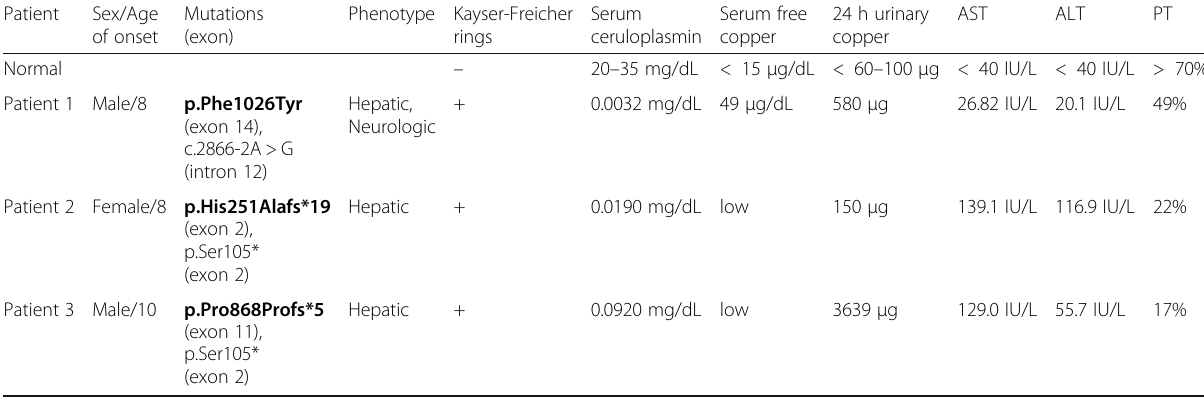
Table 2 Wilson disease patient clinical data summary